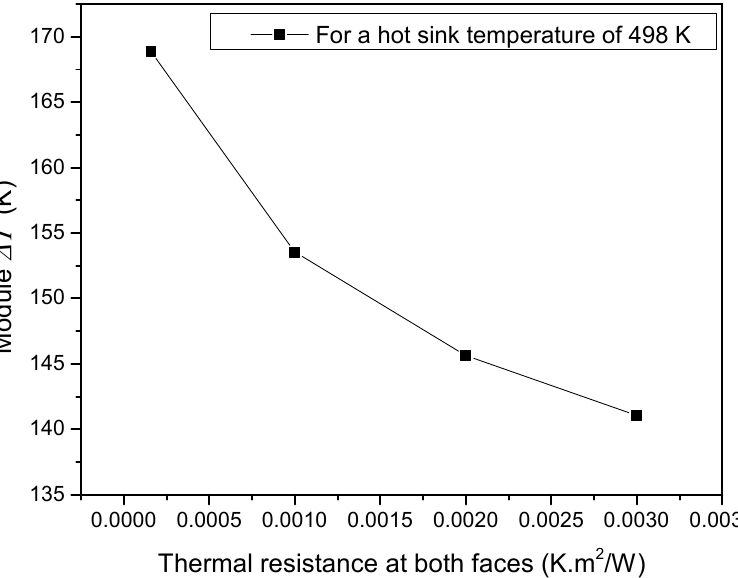
Figure 10. Influence of TEG surface thermal resistance on module ∆ T . Simulations were performed using the GM200 device.